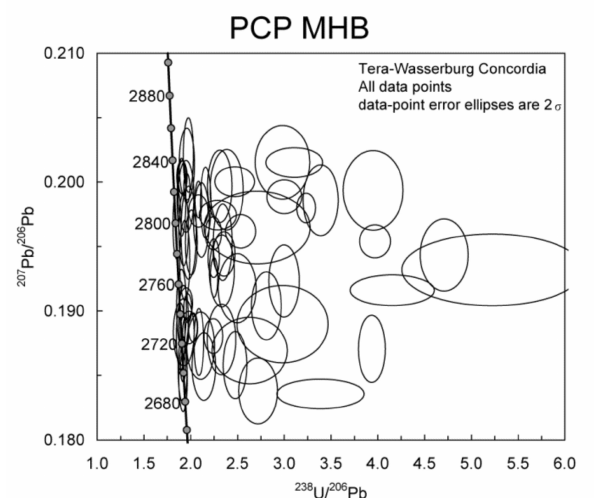
Figure 4. Unfiltered concordia plot and a probability distribution plot of filtered 207 Pb / 206 Pb ages for sample PCP-Medicine Hat, showing the wide range of concordant analyses. See text for